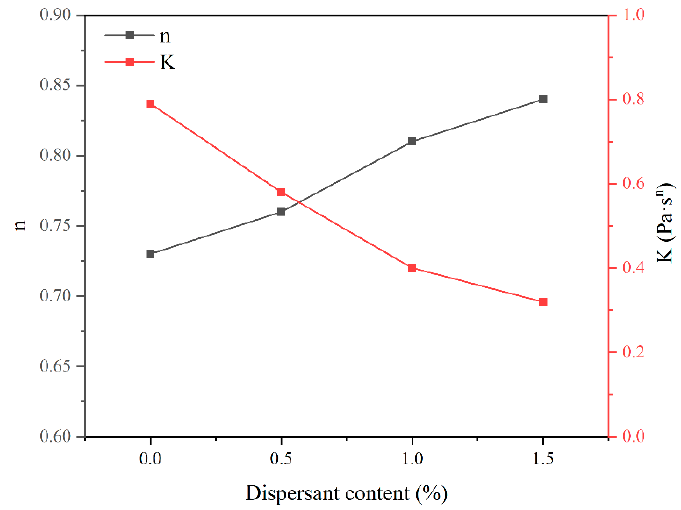
Figure 6. Rheology versus dispersant content.